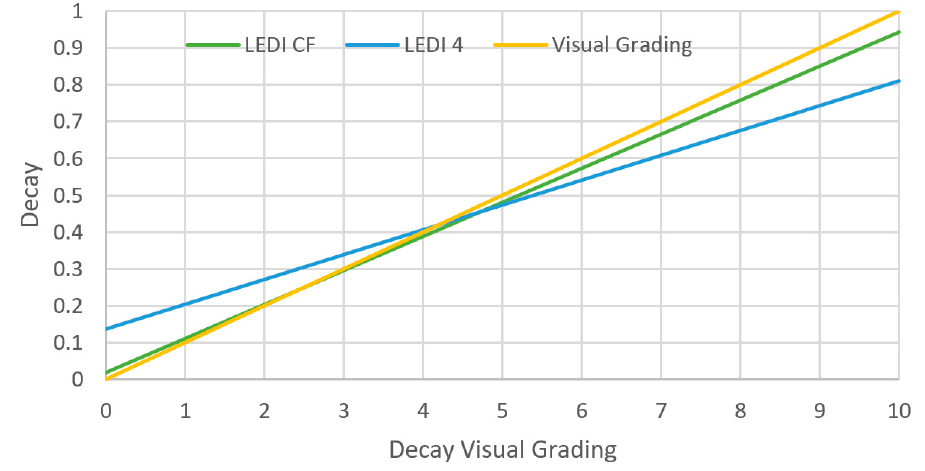
Figure 6. Decay detection of lettuce with LEDI 4 and LEDI CF versus visual rating, the black line represents the theoretical perfect match. (Reproduced with permission from Postharvest Biology and Technology journal [59]).